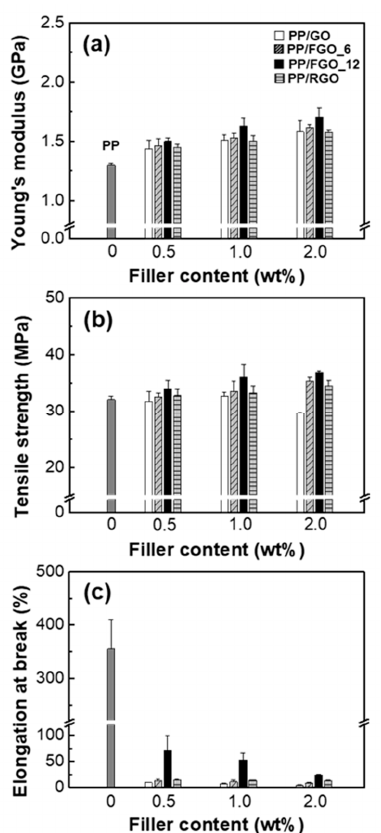
Figure 6. Mechanical properties measurement: ( a ) Young’s modulus, ( b ) tensile strength and ( c ) elongation at break of PP, PP/GO, PP/FGO_6, PP/FGO_12 and PP/RGO composites as a function of filler content.